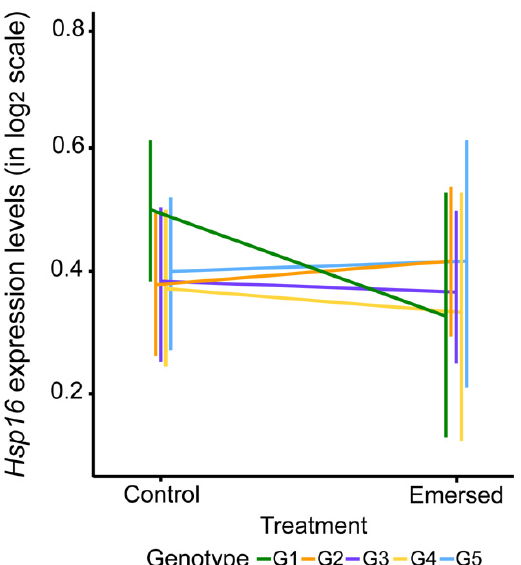
Figure 2. Reaction norms of all genotypes showing changes in Hsp16 expression level following exposure to increased emersion duration.